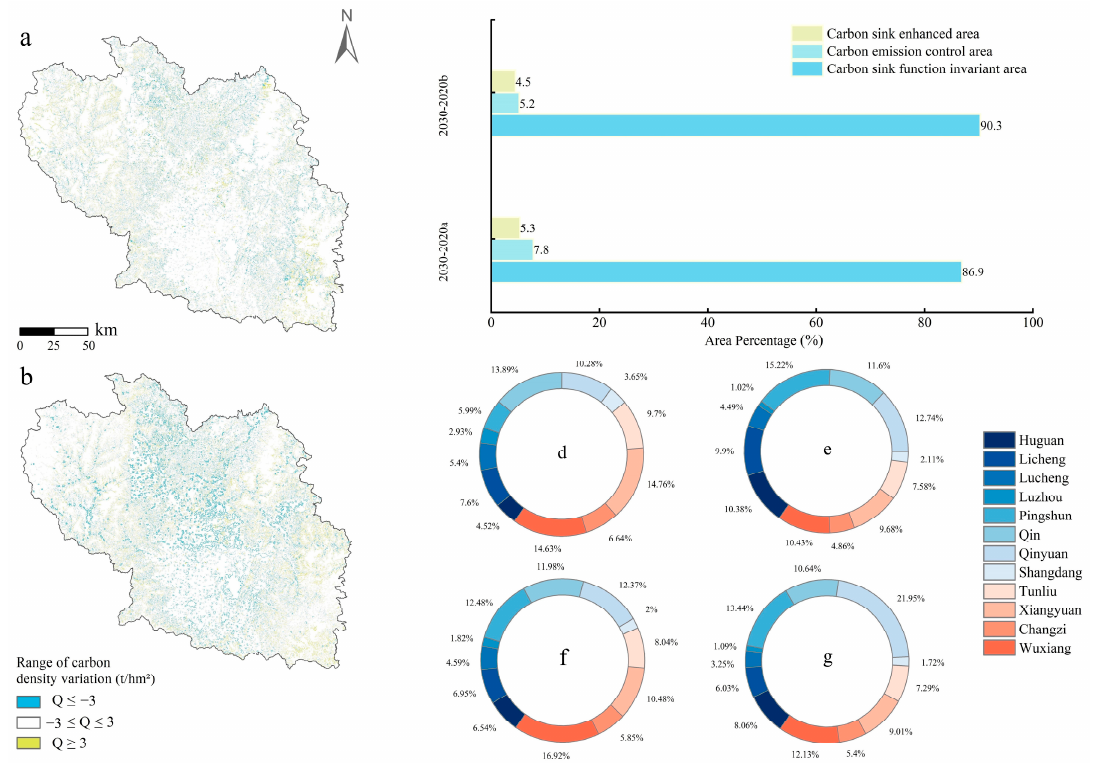
Figure 13. Spatial distribution of carbon density and carbon function areas in Changzi County from 2020 to 2030. ( a , b ) are the carbon sink function zoning maps in 2020 − 2030 under ND scenario and CD scenario, respectively; the bars show the area share of each carbon sink function zone; the ring shows the area share of carbon emission zone and carbon sink function enhancement zone in each county, ( d ) is the carbon emission area in 2020 − 2030 under ND scenario, ( e ) is the carbon sink enhancement area in 2020 − 2030 under ND scenario, ( f ) is the carbon emission area in 2020 − 2030 under CD scenario, and ( g ) is the carbon sink enhancement area in 2020 − 2030 under CD scenario. Table 5. Changes in carbon stocks for each LULC class from 2020 to 2030.